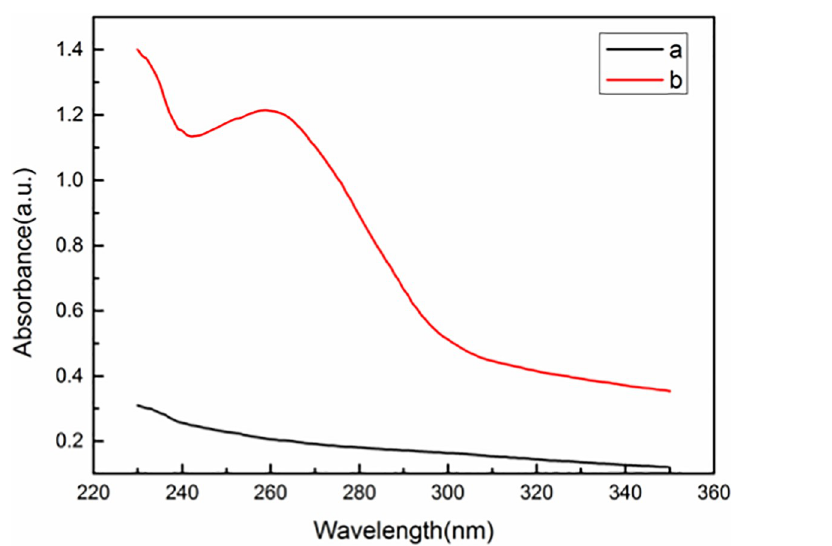
Fig 5. UV-vis absorption spectrum of MNPs@aptamer (curve a) and aptamer (curve b).